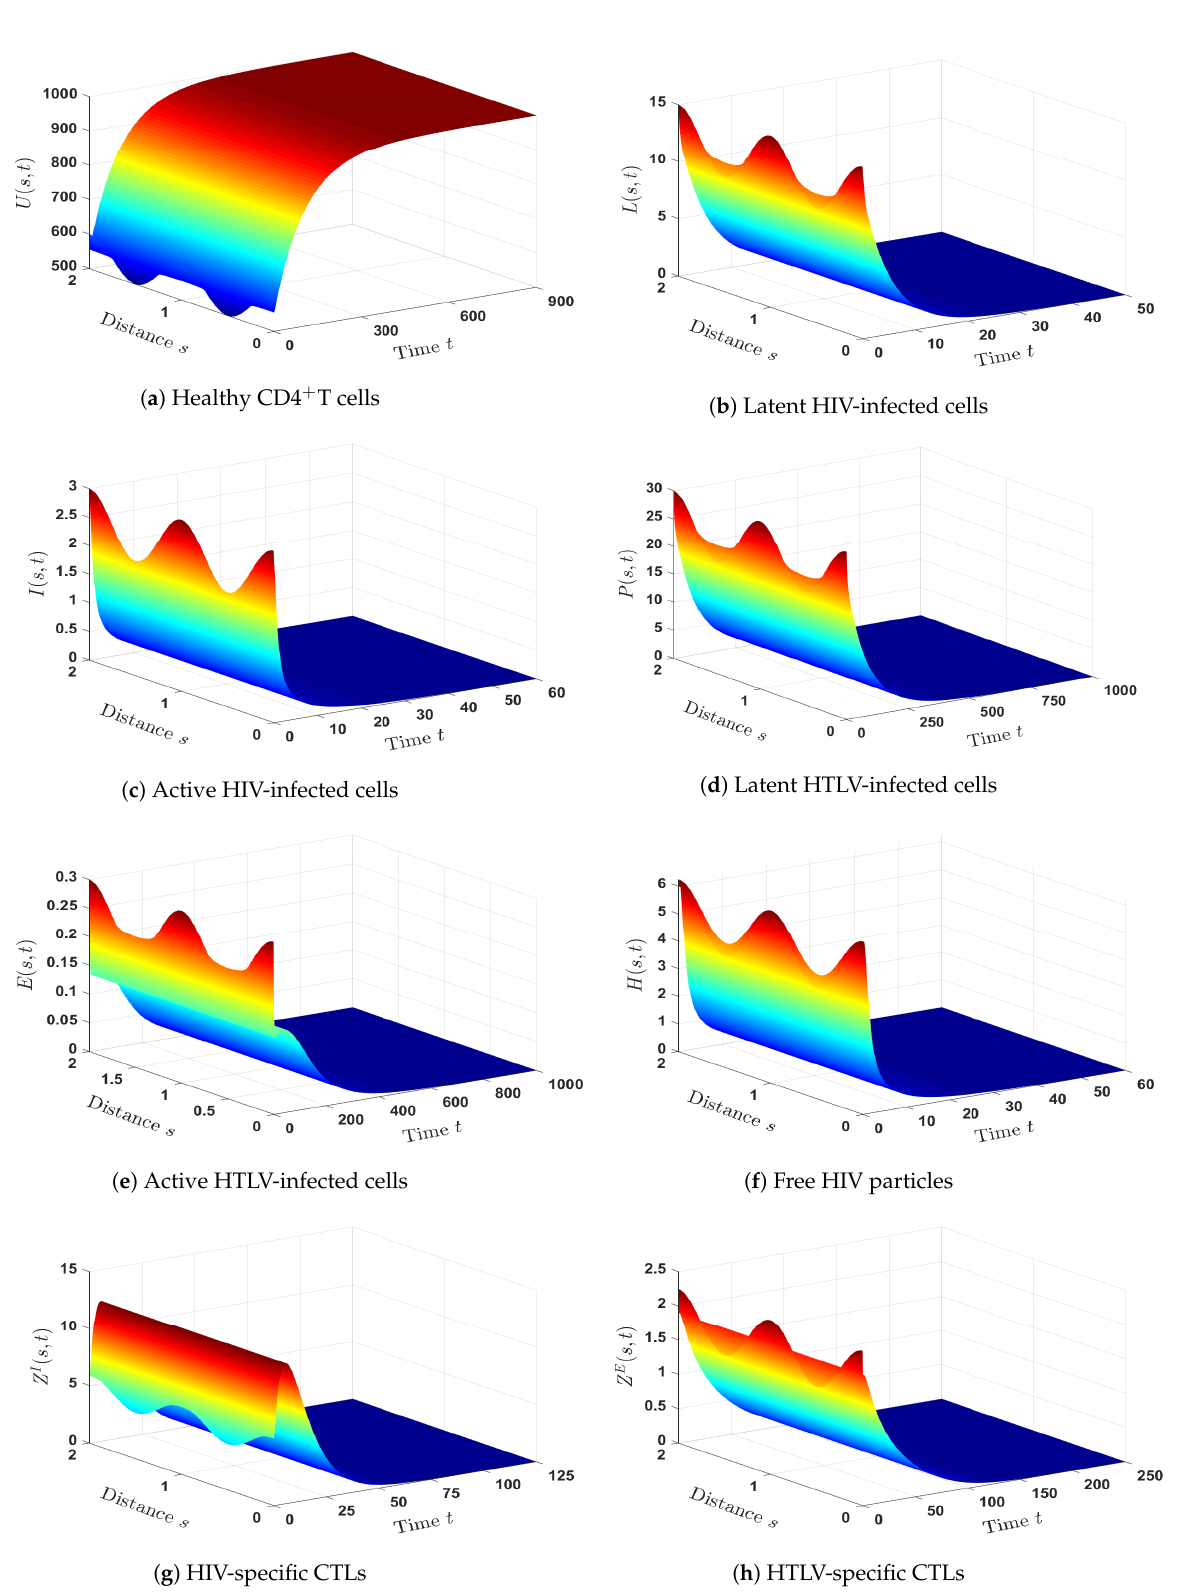
Figure 1. The solution behavior of Model (1) with the initial conditions (26) and boundary conditions (27). Taking ω 1 = 0.00006, ω 2 = 0.00005, ω 3 = 0.00007, ω 4 = 0.001, υ 1 = 0.3, υ 2 = 0.5, we have R 1 = 0.63 < 1, R = 0.23 < 1, and the equilibrium ˇ S = ( 1000,0,0,0,0,0,0,0 ) is asymptotically 2 0